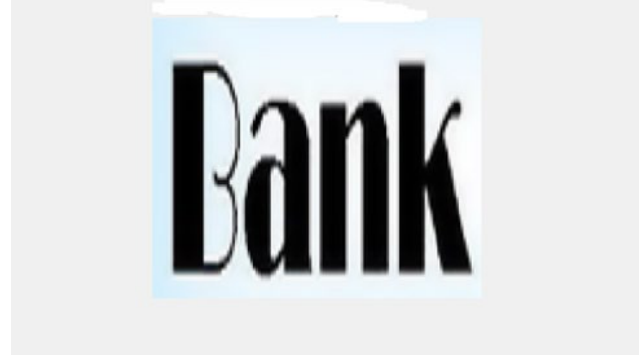
Figure 6. Extracted textual images after applying deep